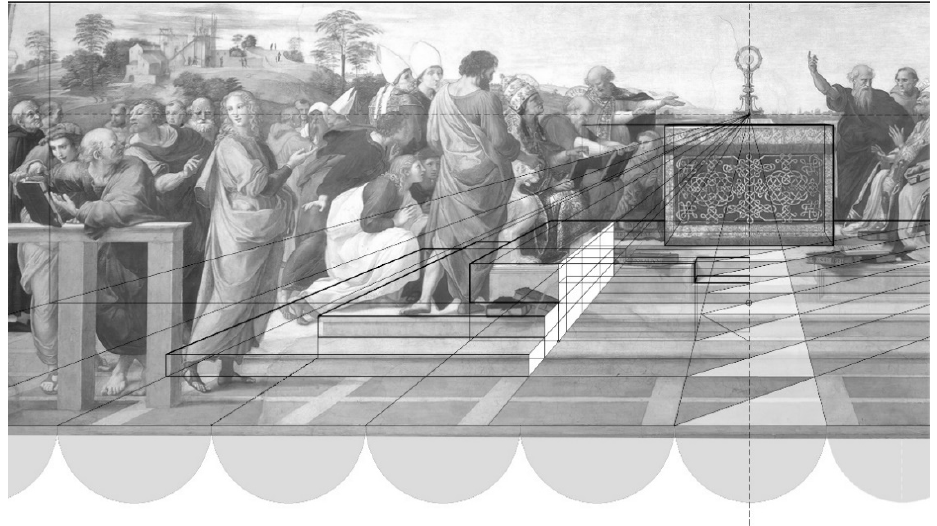
Figure 15. Reconstruction of the perspective structure of the steps under the altar of Raffaello’s The Disputa .